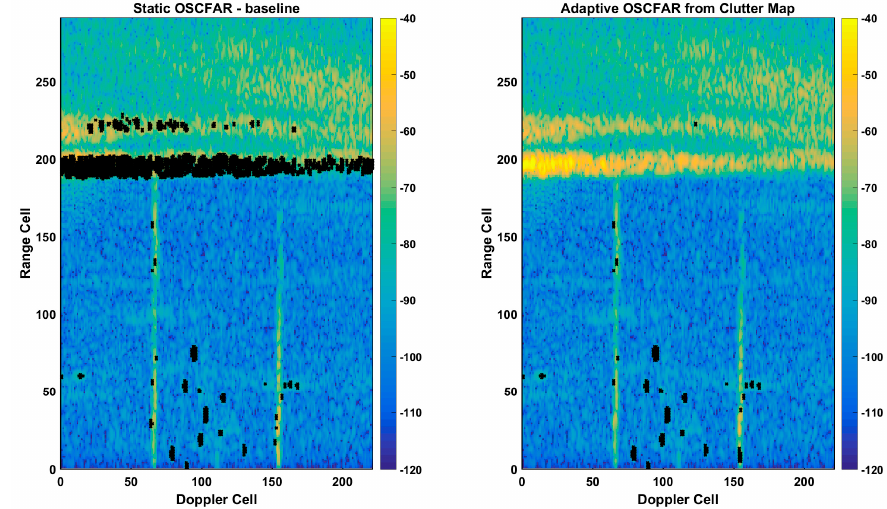
Figure 9. Range–Doppler plane with baseline CFAR detection overlay ( left ) and adaptive CFAR detections overlay ( right ) showing an approximately 90% reduction in CFAR detection with adaptive CFAR.